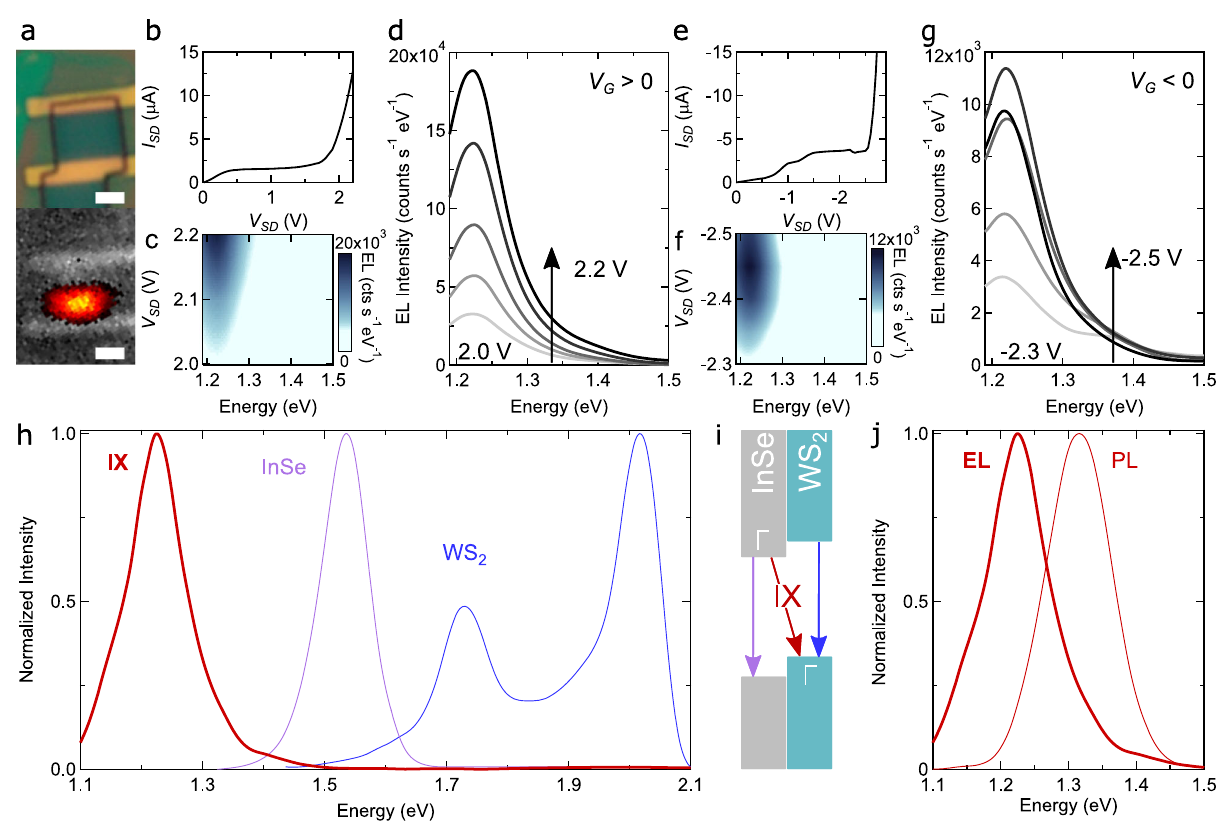
Fig. 3 Electroluminescence from a Γ – Γ interface. a Images of the channel of a transistor based on a 2L-WS 2 /4L-InSe heterostructure taken with an optical microscope (top) and with the camera of our spectrometer (bottom). The bottom image, taken with the device biased at the onset of the ambipolar injection regime, shows a bright spot due to EL. The scale bars are 1 μ m. b Device output curve measured at, V G = + 0.5 V (electron accumulation). c False- color plot of the EL intensity measured by the spectrometer, as a function of photon energy and applied V SD , showing a peak centered around 1.25 eV that emerges at V SD = + 1.9 V, corresponding to the onset of ambipolar injection (see b ). d Individual EL spectra at selected V SD values extracted from c : in this bias range the spectrum remains unchanged, and the intensity increases following the increase in source-drain current. e – g Data analogous to those of panels b – d are shown for V G = – 2.2 V (hole accumulation), demonstrating that the presence of EL is robust and that at suf fi ciently low bias the spectrum is virtually identical for electron and hole accumulation. h The peak in the EL spectrum (acquired with V SD = + 2.2 V and V G = + 0.5 V) is red-shifted relative to the PL emission energies of the layers forming the interface (purple: 4L Inse; blue: 2L-WS 2 ; for InSe, PL data are taken at 5 K, because no PL is observed at room temperature), as expected from an interlayer Γ – Γ transition (see i ). j Comparison between the normalized EL (thick red line) and PL (thin red line) emission spectra of the interface. The energy difference originates from having to measure PL at cryogenic temperatures ( T = 5 K), since no PL is observed at room